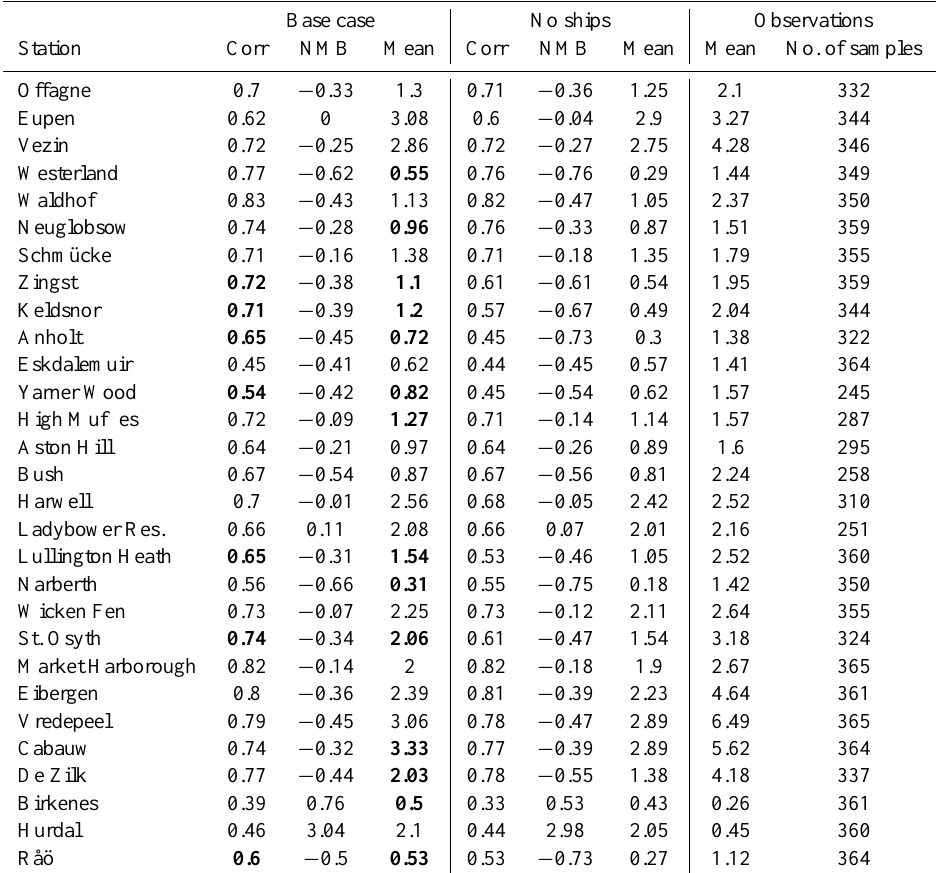
Table 5. Comparison of simulated NO 2 concentrations with observations in µgm − 3 . Values that are significantly different between the base case and the no-ships case are printed in bold.